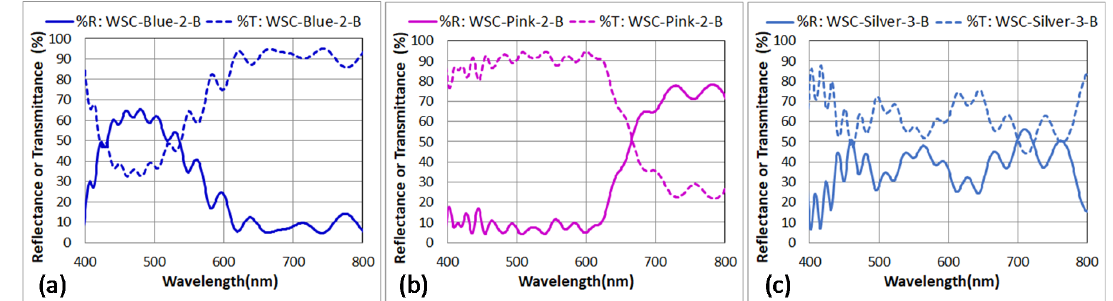
Figure 4. Reflectance (8 degrees light incidence) and transmittance (0 degrees) for Design Strategy 2 hard coating samples: ( a ) WSC-Blue-2-B, ( b ) WSC-Pink-2-B, and ( c ) WSC-Silver-3-B. Wavelength selectivity is broadly tunable through the interference layer design. High wavelength selectivity is demonstrated using Design Strategy 2, which uses buried interference layers to maximize hardness. A stopband passband reflectance ratio of >6:1 is demonstrated for ( a ) WSC-Blue-2-B and >7:1 for ( b ) WSC-Pink-2-B.